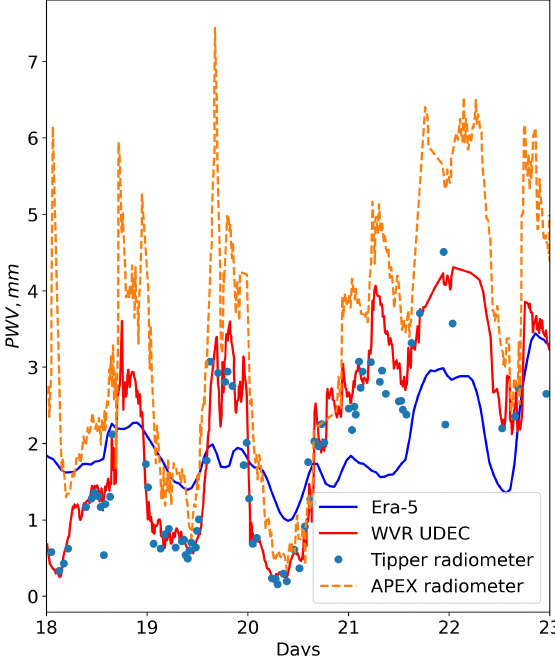
Figure 3. PWV variations for a period of five days in the Chajnantor area for the period 18 December 2011–23 December 2011. The blue line corresponds to the calculated Era-5 PWV variations. The red line and round markers correspond to the PWV variations at the Cerro Chajnantor summit. The orange line corresponds to the PWV variations at the Chajnantor Plateau.